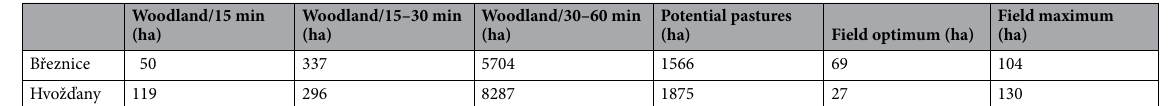
Woodland/15 min